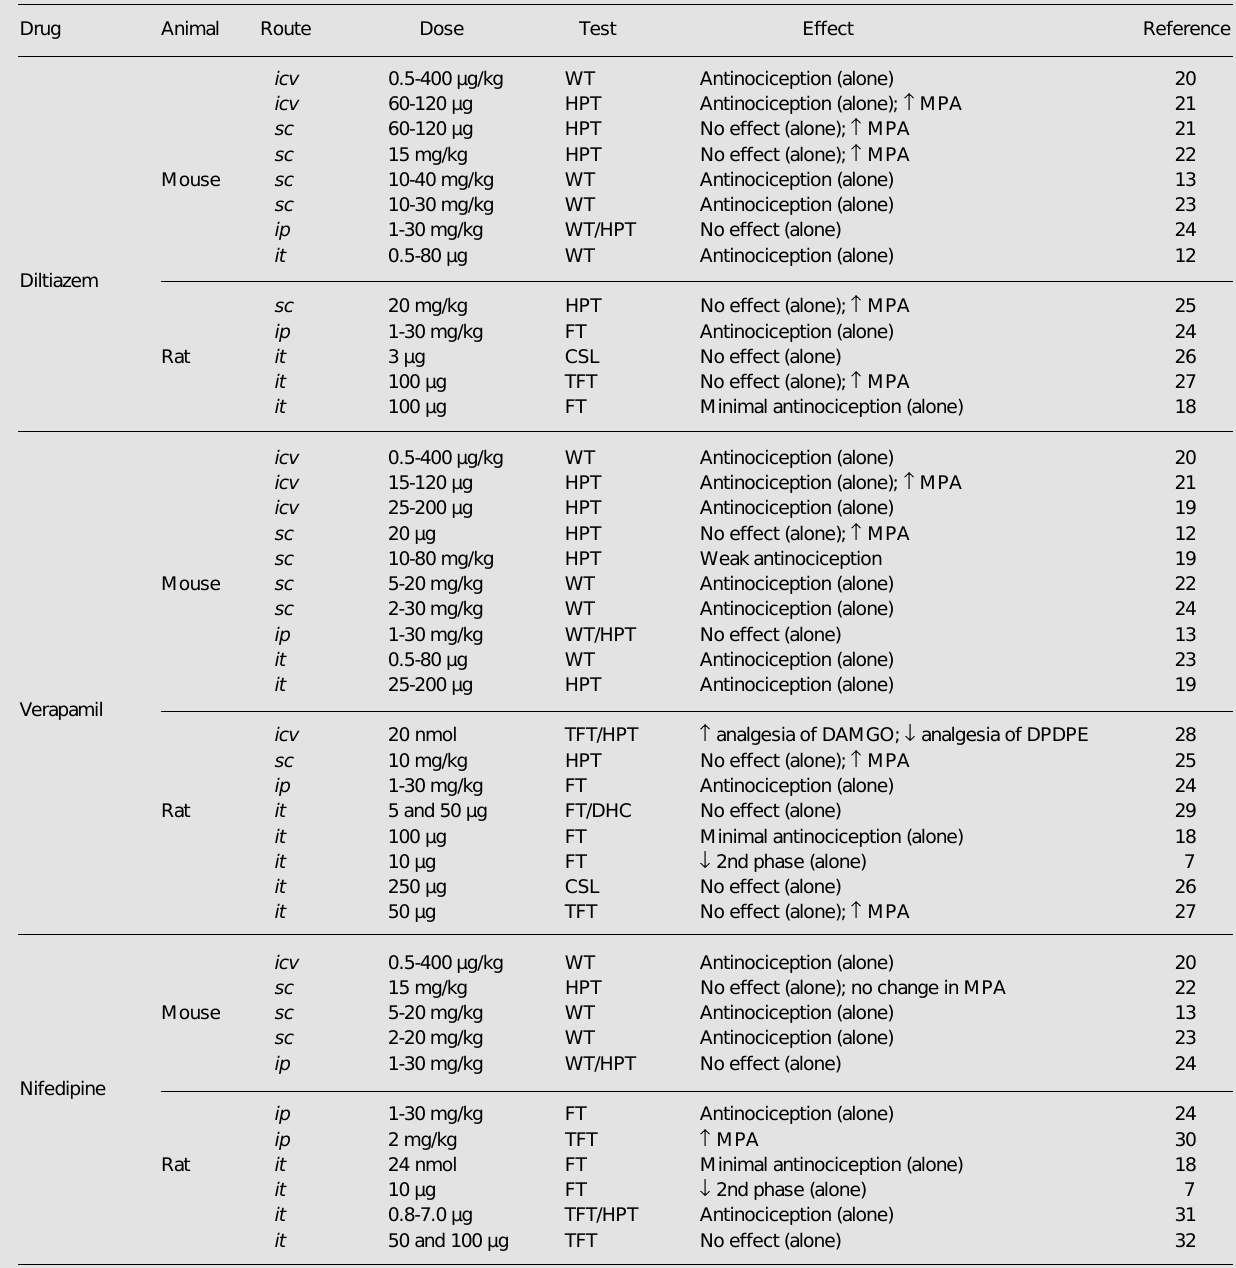
Table 3 - Effects of L-type Ca 2+ -channel antagonists on nociception and opioid-induced antinociception. CSL = Chronic sciatic ligature; DHC = dorsal horn cell electrical activity. For other abbreviations see legend to Table